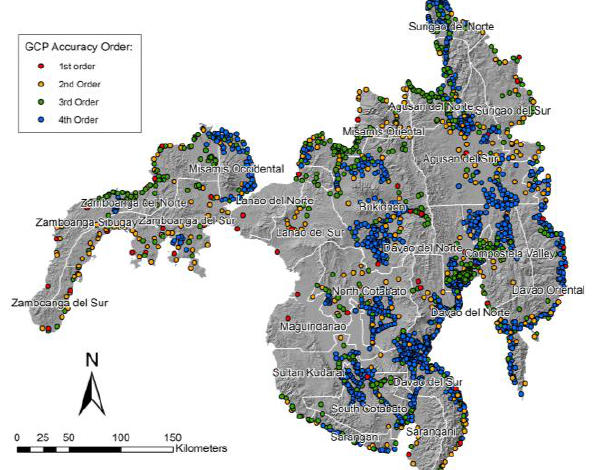
Figure 3. Map showing the ground control points (GCPs) used in the vertical accuracy and uncertainty assessment.